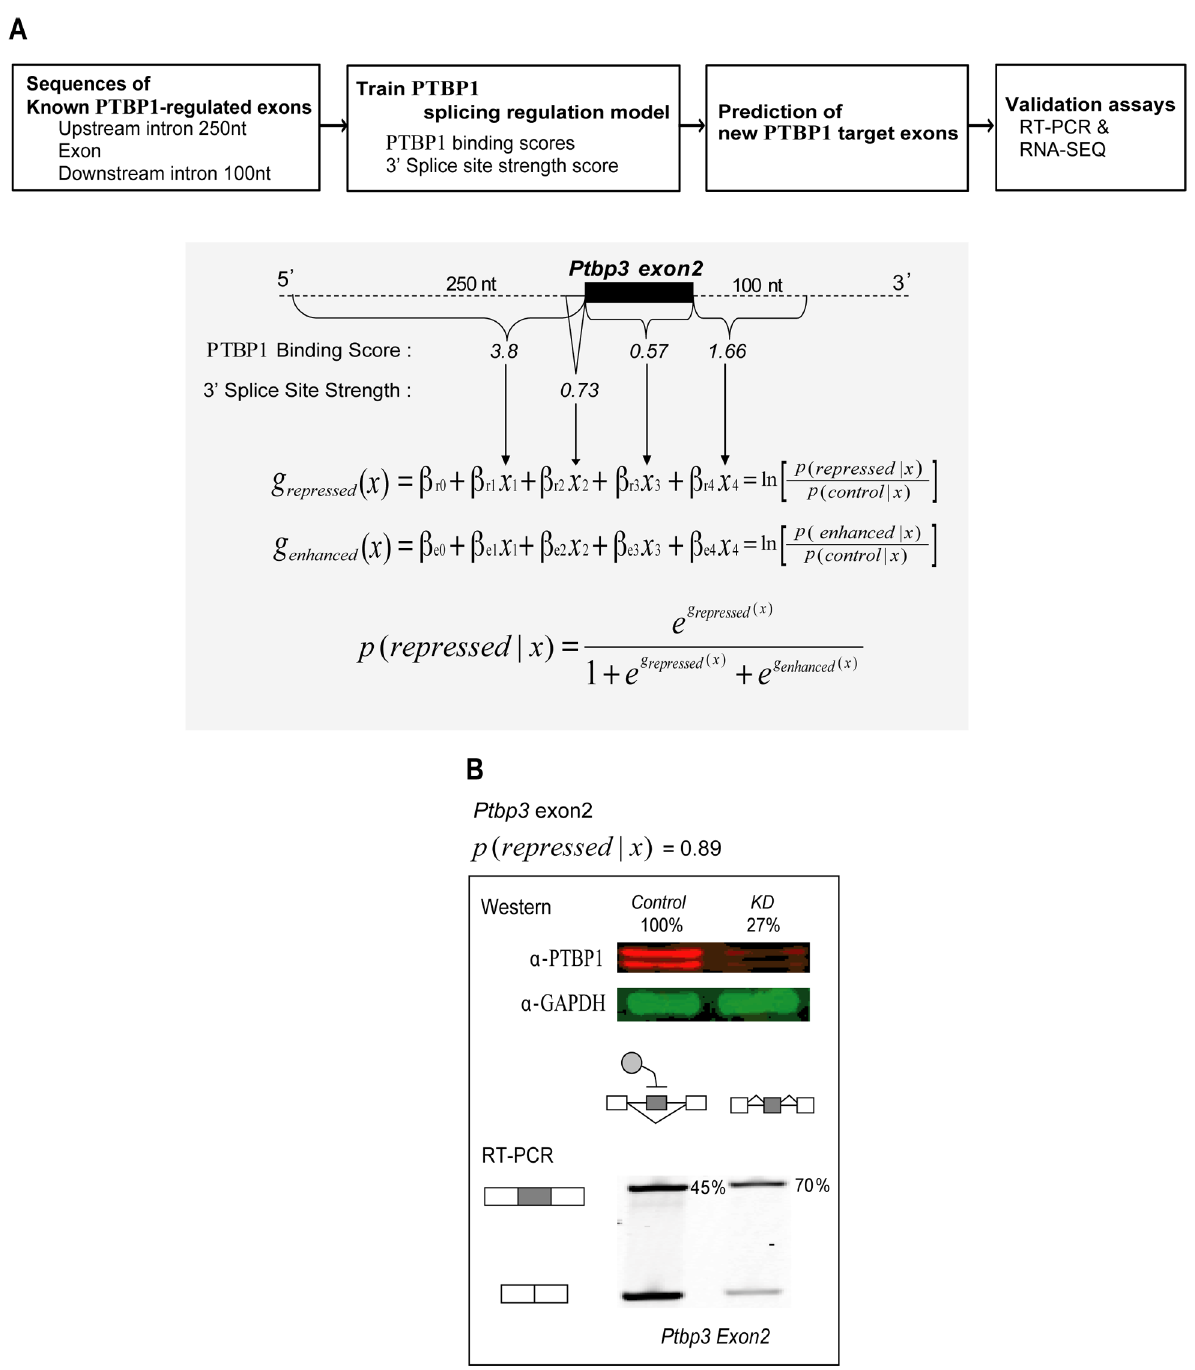
Figure 4. Scheme of the PTBP1 splicing regulation model and its application to an exon in Ptbp3 . A . The PTBP1 splicing regulation model was trained on known PTBP1-regulated and non-regulated exons and used to predict new PTBP1-dependent exons. Prediction results were compared to changes in exon inclusion (PSI) measured by RT-PCR and RNA-seq. An exon from Ptbp3 is presented as a prediction example. From intron and exon sequences, PTBP1 binding scores and 3 9 splice site strength were calculated and fed into the regulation model. B . The model predicts exon 2 of Ptbp3 as repressed by PTBP1 with high probability (0.89). Ptbp1 knockdown in mouse neuroblastoma cells ( N2A ) confirmed de-repression of the exon (from PSI=45 to PSI=70). specificity across the range of scores to define a decision threshold numbers of repressed exons. We sought to choose a threshold that gave a low false positive rate over one that yielded more regulated for exon repression scores (Figure S6B). Increasing the threshold increases the specificity by eliminating many false positives, but exons. We found that above a threshold score of 0.65 the false decreases the sensitivity of the model in identifying maximum positive rate was 10% or lower (Figure S6B).